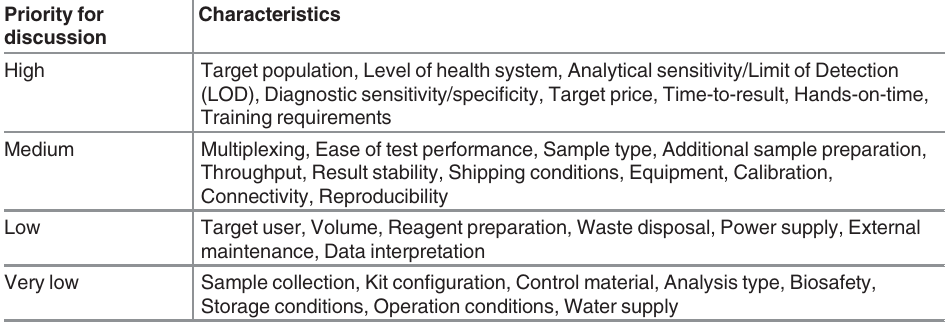
Table 1. Target product profile characteristics and their priority, expert consensus process 2015 –